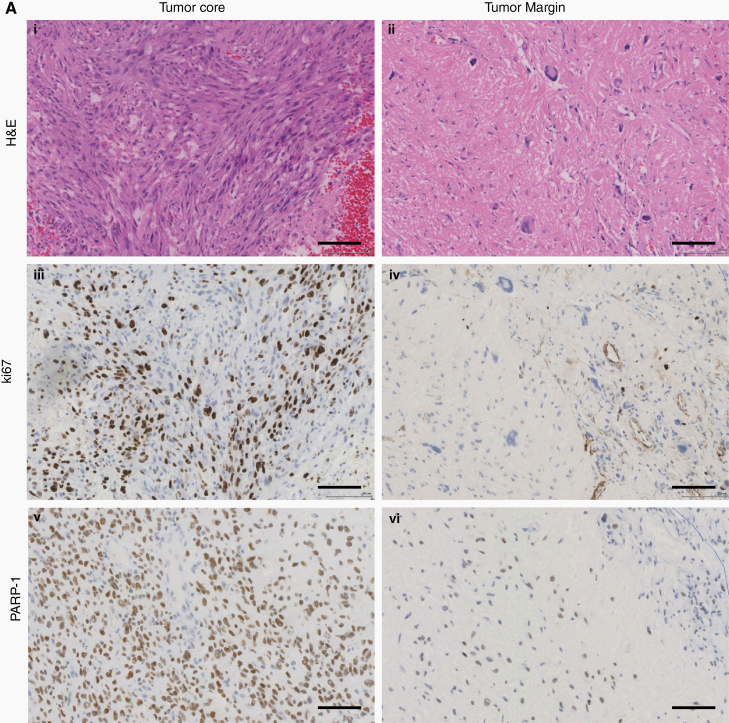
Immunohistochemical analysis of OPARATIC tumor specimens. (A) Representative images of histological sections obtained from a single patient in the dose expansion cohort: H&E (x20) of (i) tumor core and (ii) tumor margin (<3% tumor cell infiltrate); Ki67 immunohistochemistry (x20) of (iii) tumor core and (iv) tumor margin; PARP-1 IHC (x20) of (v) tumor core and (vi) tumor margin showing nuclear immunopositivity. (B) Quantitative analysis of (i) capillary area, detected by CD31 staining; (ii) percentage of PARP-1 positive nuclei; and (iii) percentage of Ki67 positive nuclei in tumor margin specimens from 6 patients in the dose expansion cohort, plotted alongside corresponding olaparib concentrations (red). Stained sections were image captured on Leica Slidepath and image analysis performed using the HALO platform.